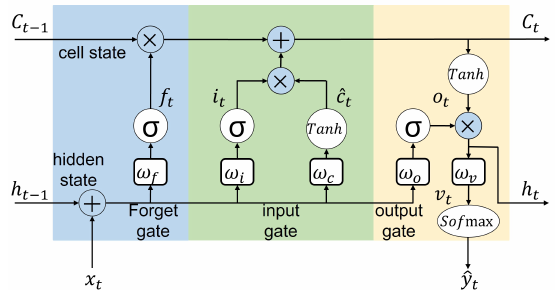
Figure 4. LSTM architecture and memory